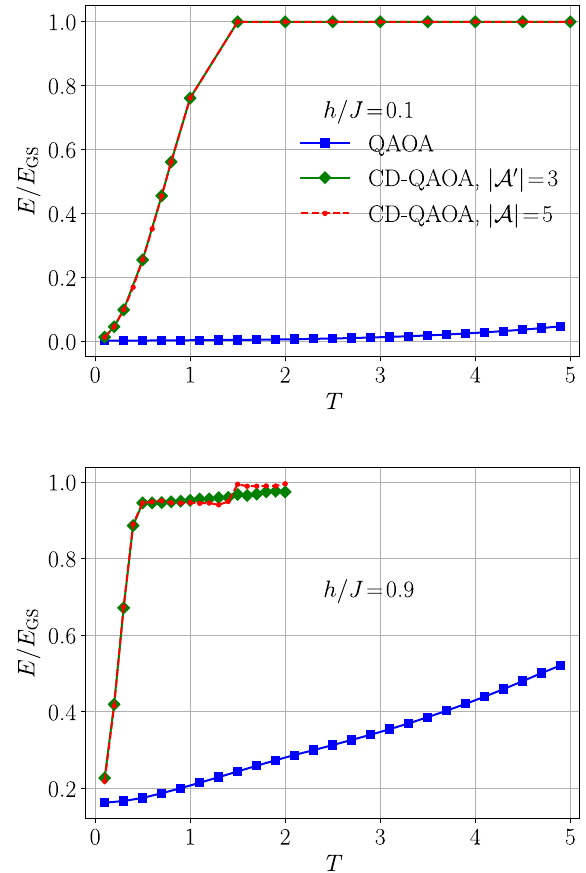
FIG. 22. LMG model: energy minimization against protocol duration T using conventional QAOA (blue square) and CD- QAOA (red dashed line, green solid line). The model parameters are the same as in Fig. 5 but for h=J ¼ 0 . 1 (top panel) and h=J ¼ 0 . 9 (bottom